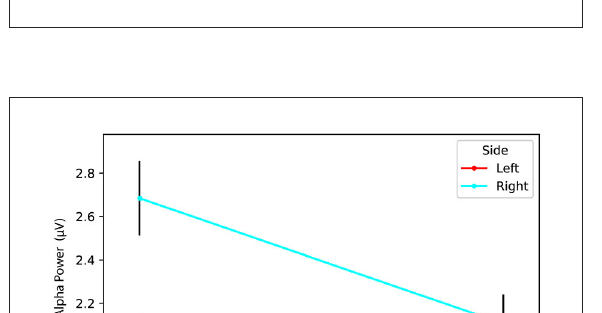
FIGURE10 Unsuccessful Blocks. Both Right and Left alpha power decrease from View to Engage , although Left to a greater (significant) extent.